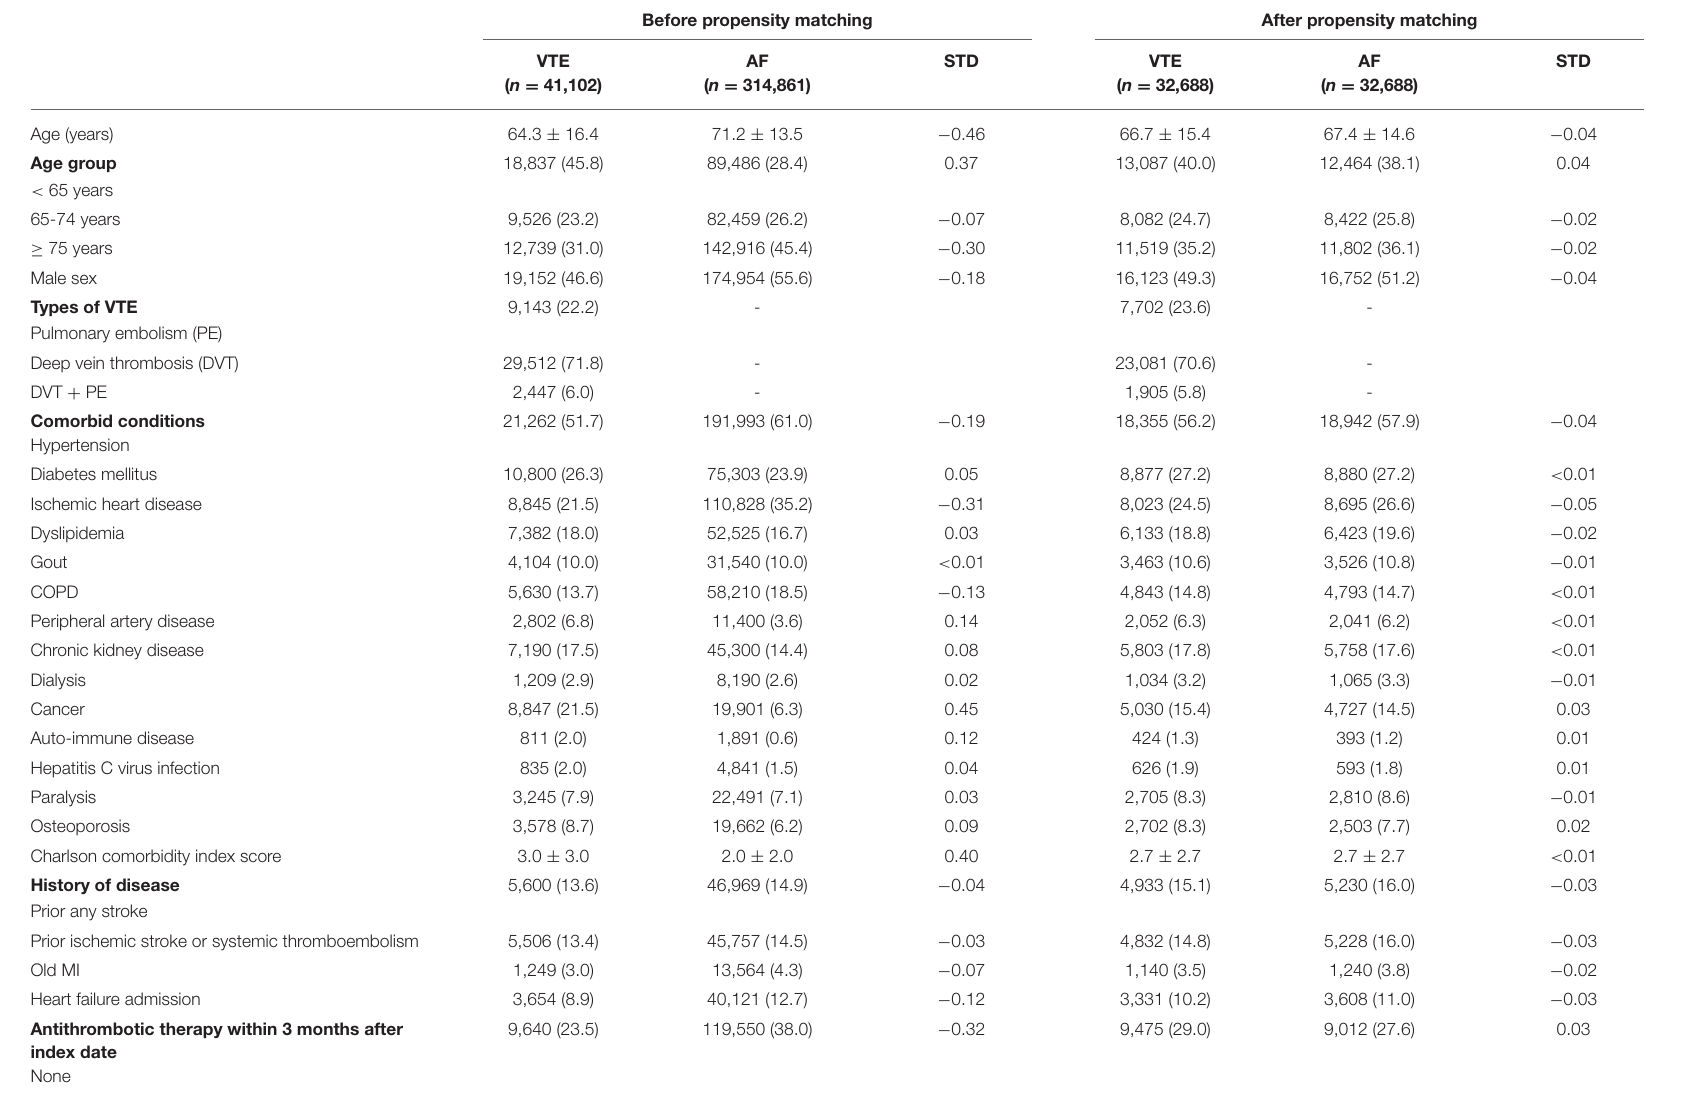
TABLE 1 | Baseline characteristics of the patients diagnosed with AF or VTE. Before propensity matching After propensity